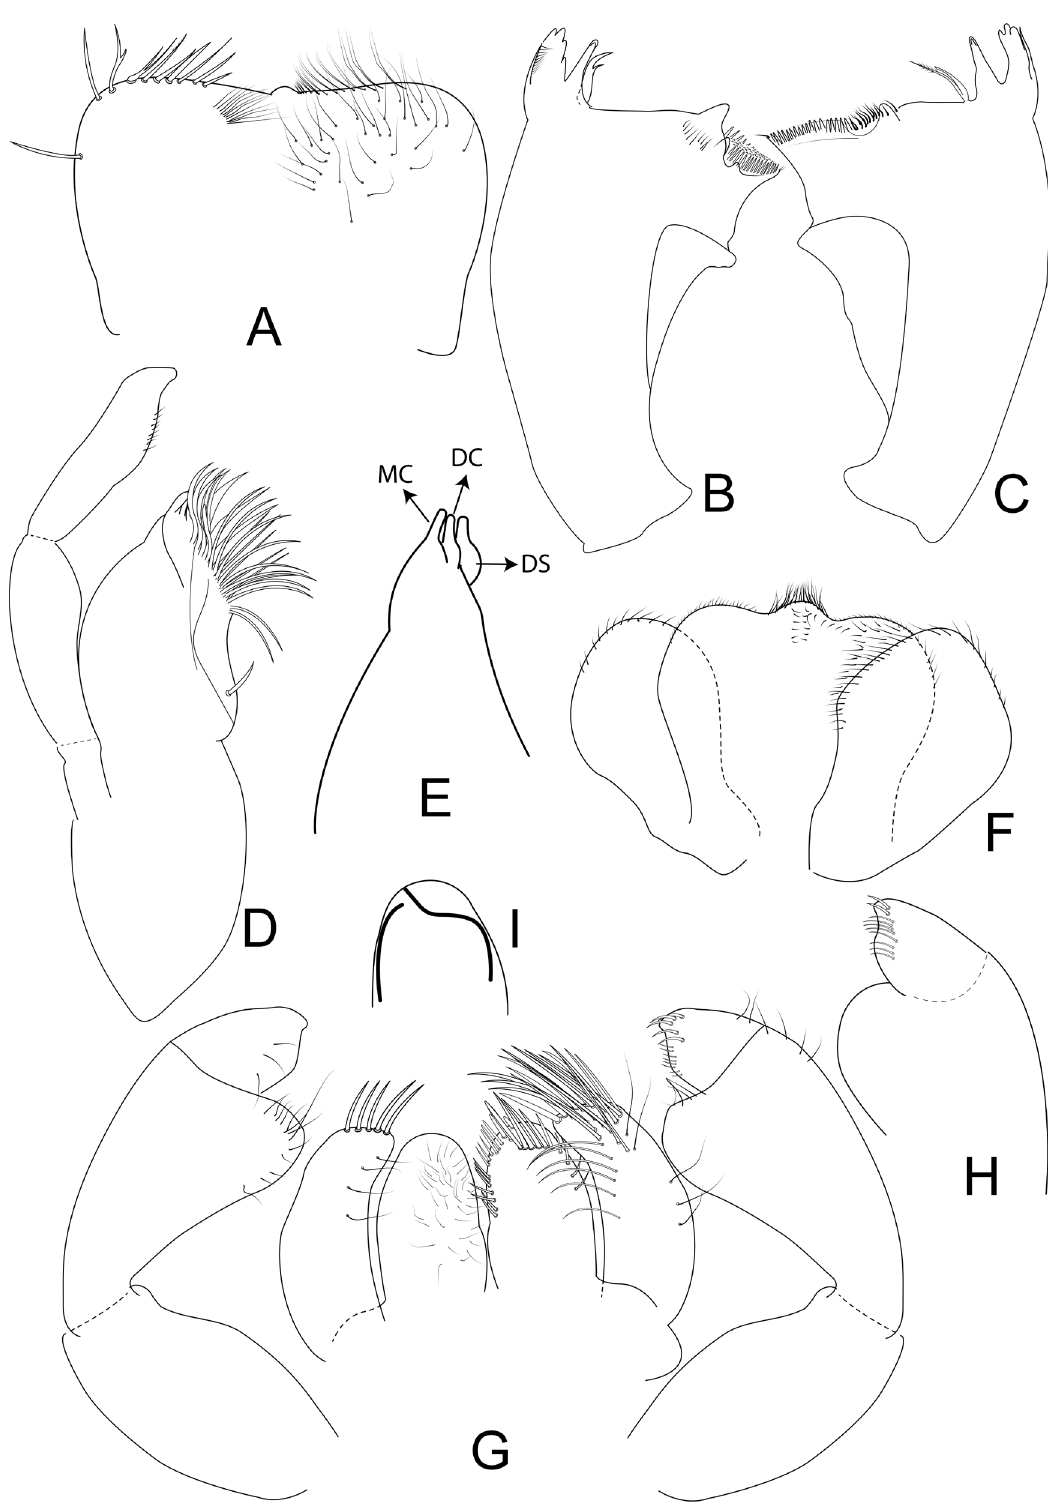
Fig. 12. Rivudiva uiara sp. nov., holotype (INPA). A . Labrum (left v.v., right d.v.). B . Left mandible. C . Right mandible. D . Maxilla. E . Apex of maxilla v.v. (DS = dentiseta, DC = dorsal canine, MC = medial canine). F . Hypopharynx. G . Labium (left v.v., right d.v.). H . Variation of apex of segment II and segment III of labial palp. I . Shape of distal rows of setae of glossa. Not to